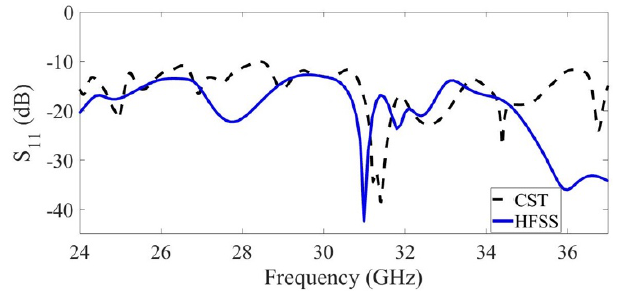
FIGURE 3. Simulated reflection coefficient of Linear and exponentially tapered horn opening